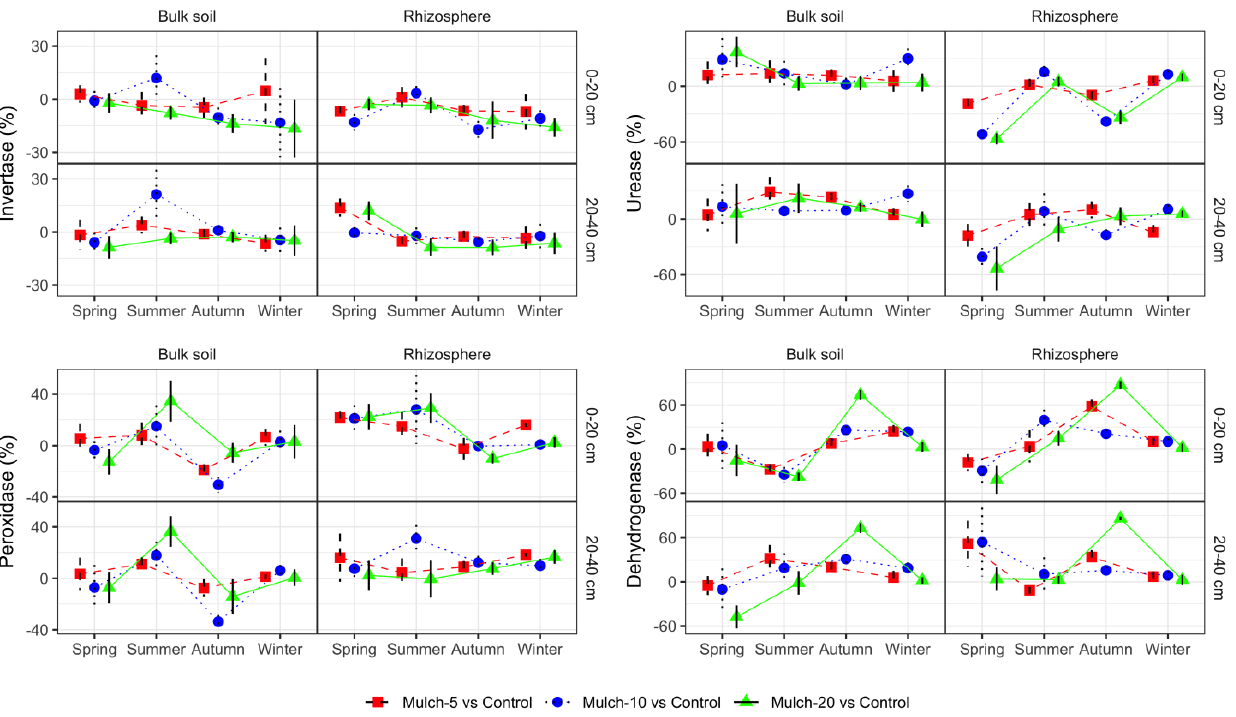
Figure 1. Differences in enzymatic activities between mulching and control in the rhizosphere and bulk soil. Values represent means ± standard errors ( n = 5). Treatments: Mulch-5, Mulch-10, and Mulch-20, corresponding to organic mulching to a depth of 5, 10 and 20 cm, respectively.